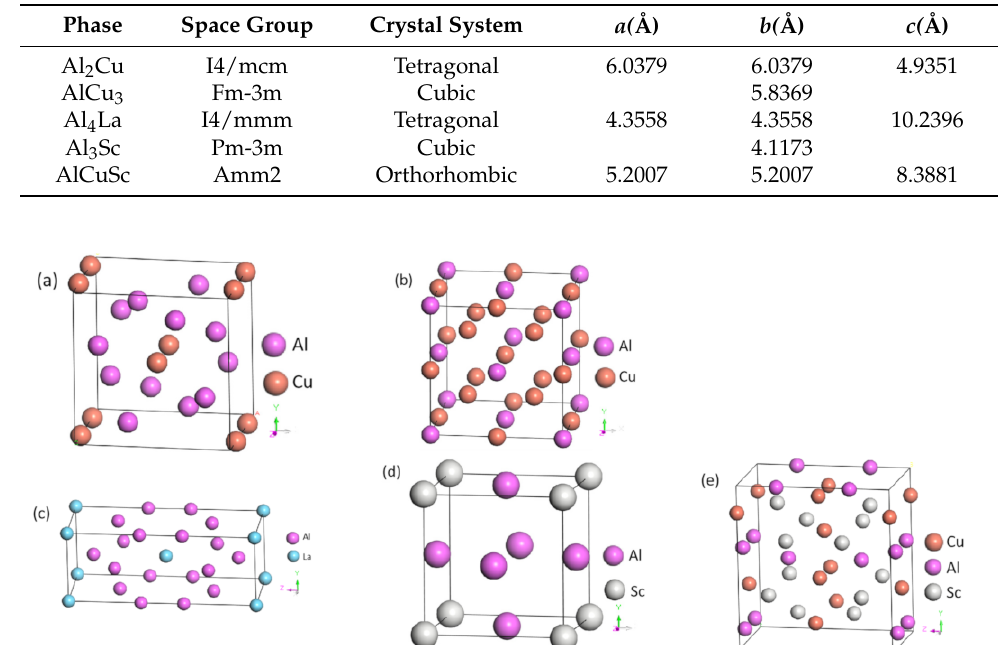
Table 3. Calculated lattice constants data of intermetallic compounds.